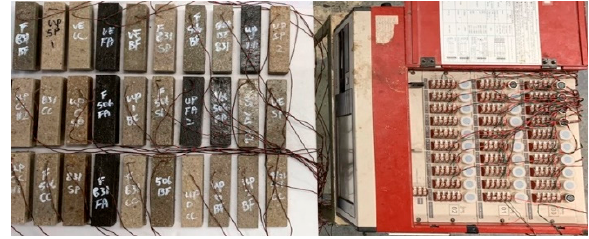
Figure 4. Test setup for measuring drying shrinkage.